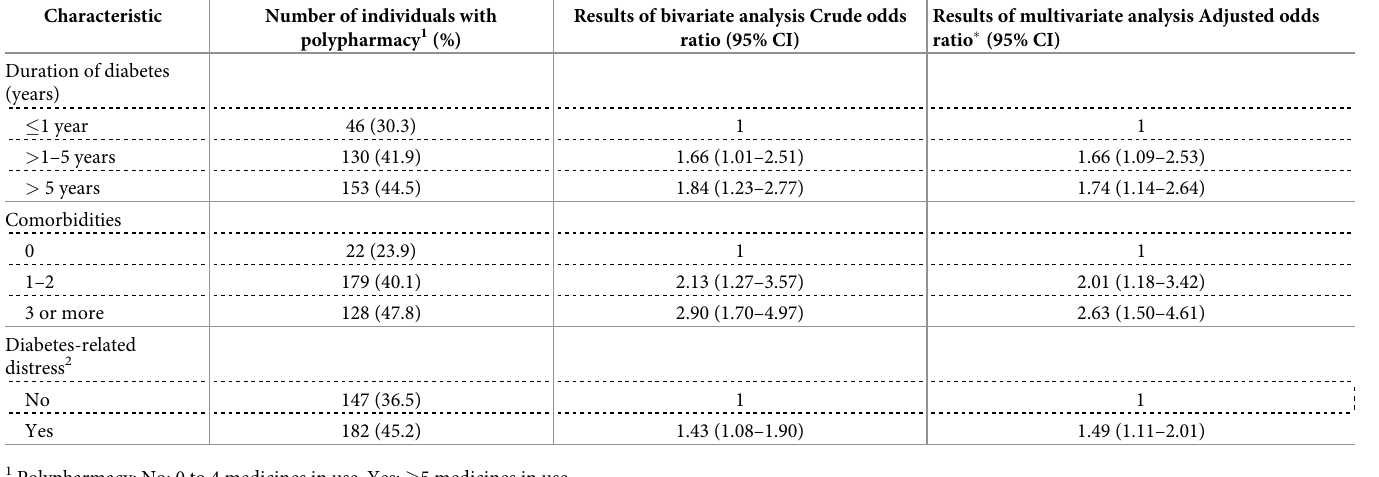
Table 3. Factors associated with